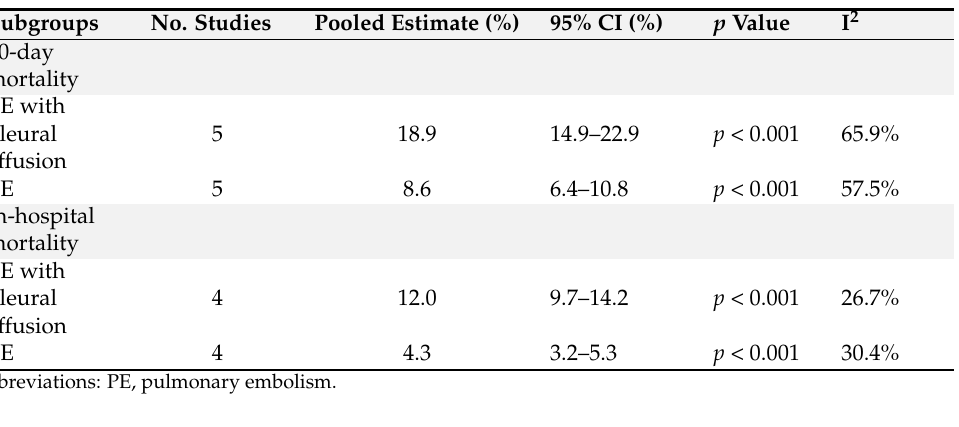
Table 3. Subgroup analysis of mortality.